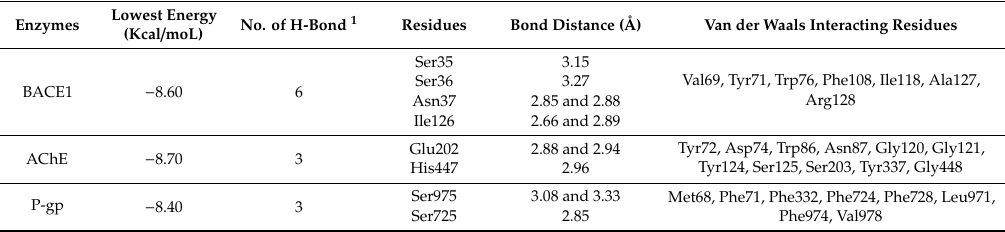
Table 3. Molecular interaction of BACE1, AChE, and P-glycoprotein (P-gp) active sites with its ligand (Baicalein).